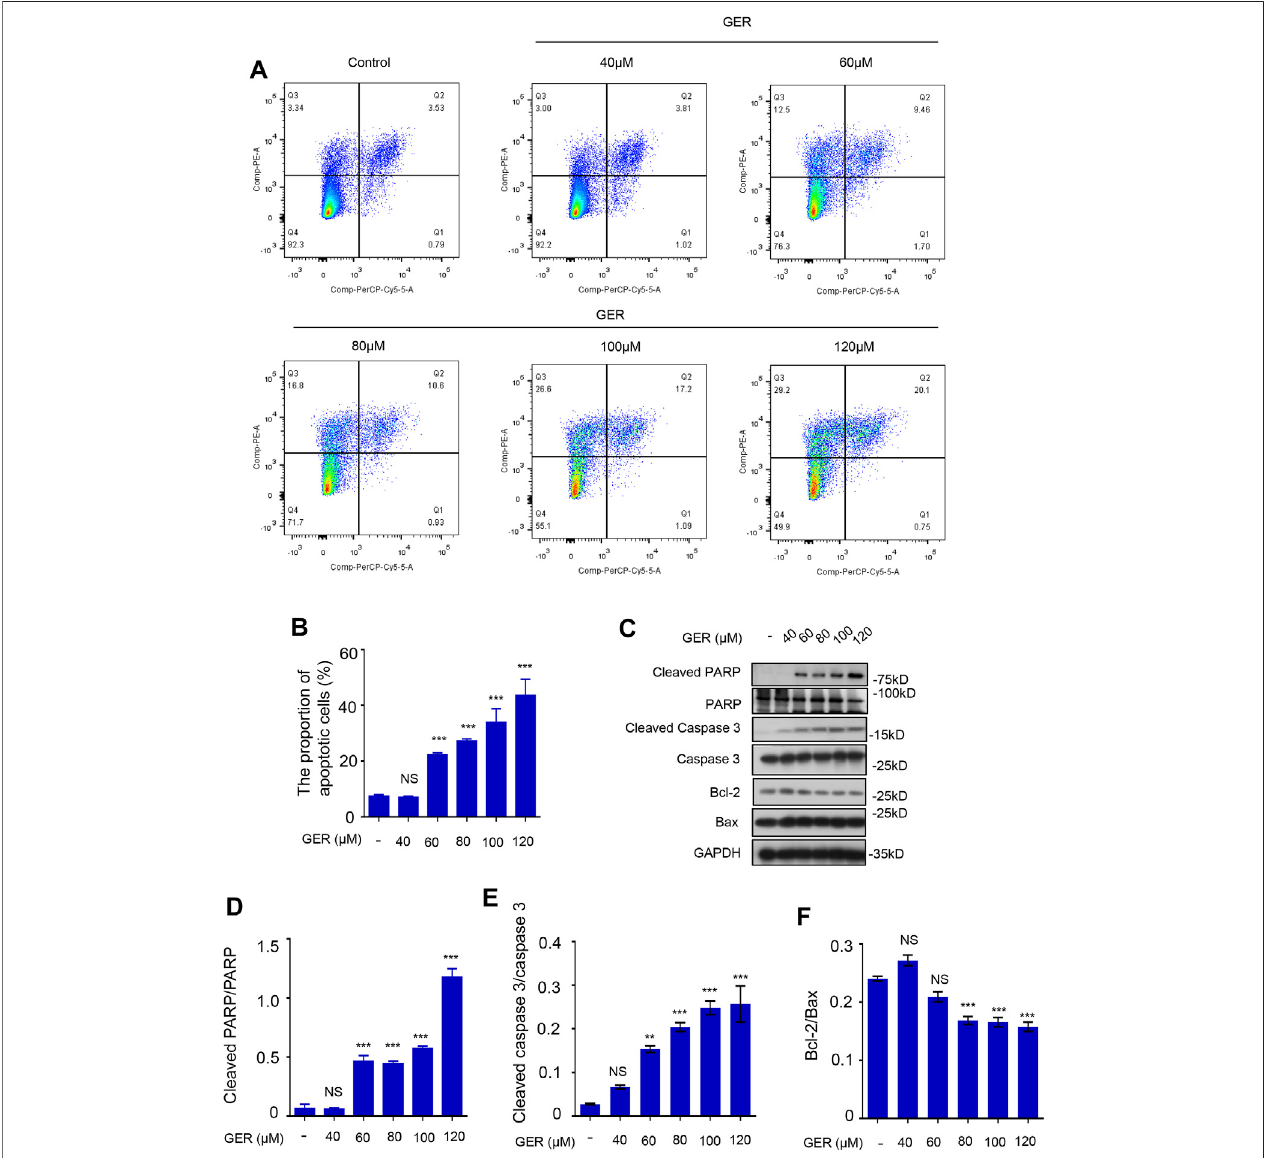
FIGURE 3 | GER promotes the apoptosis of HSCs. (A) Flow cytometric analysis of PI-stained apoptotic cells, and the cells in the upper right quadrant (Q2) were early apoptotic cells, and the cells in the upper left quadrant (Q3) were mid and late apoptotic cells. The apoptotic cells contained early, mid and late apoptotic cells. (B) QuantitativeanalysisofdifferentgroupapoptoticcellsaftertreatmentwithGER( n (cid:2) 3). (C) WesternblotforcleavedPARP,PARP,cleavedCaspase-3,Caspase-3,Bcl-2, Bax protein level in LX-2, and GAPDH was used as the loading control. (D – F) Quantitative analysis of cleaved PARP vs PARP, cleaved Caspase-3 vs. Caspase-3 and Bcl-2 vs Bax expression ( n (cid:2) 3). All data are presented as means ± SEM. * p < 0.05, ** p < 0.01, *** p < 0.001 vs. the control group. NS, non-signi fi cant vs. the control group.